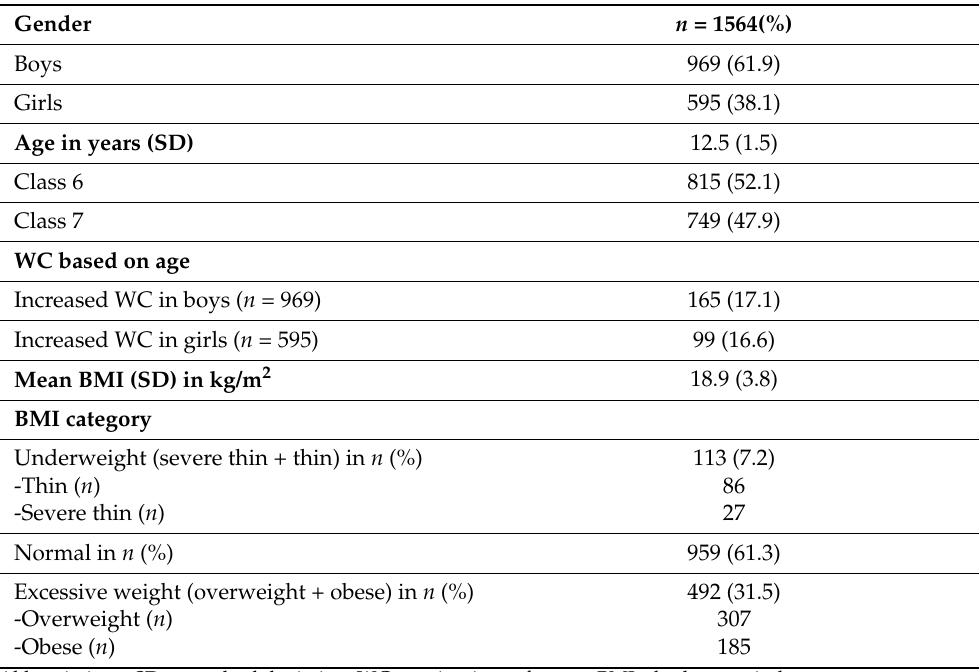
Table 1. Socio-demographic variables of the study